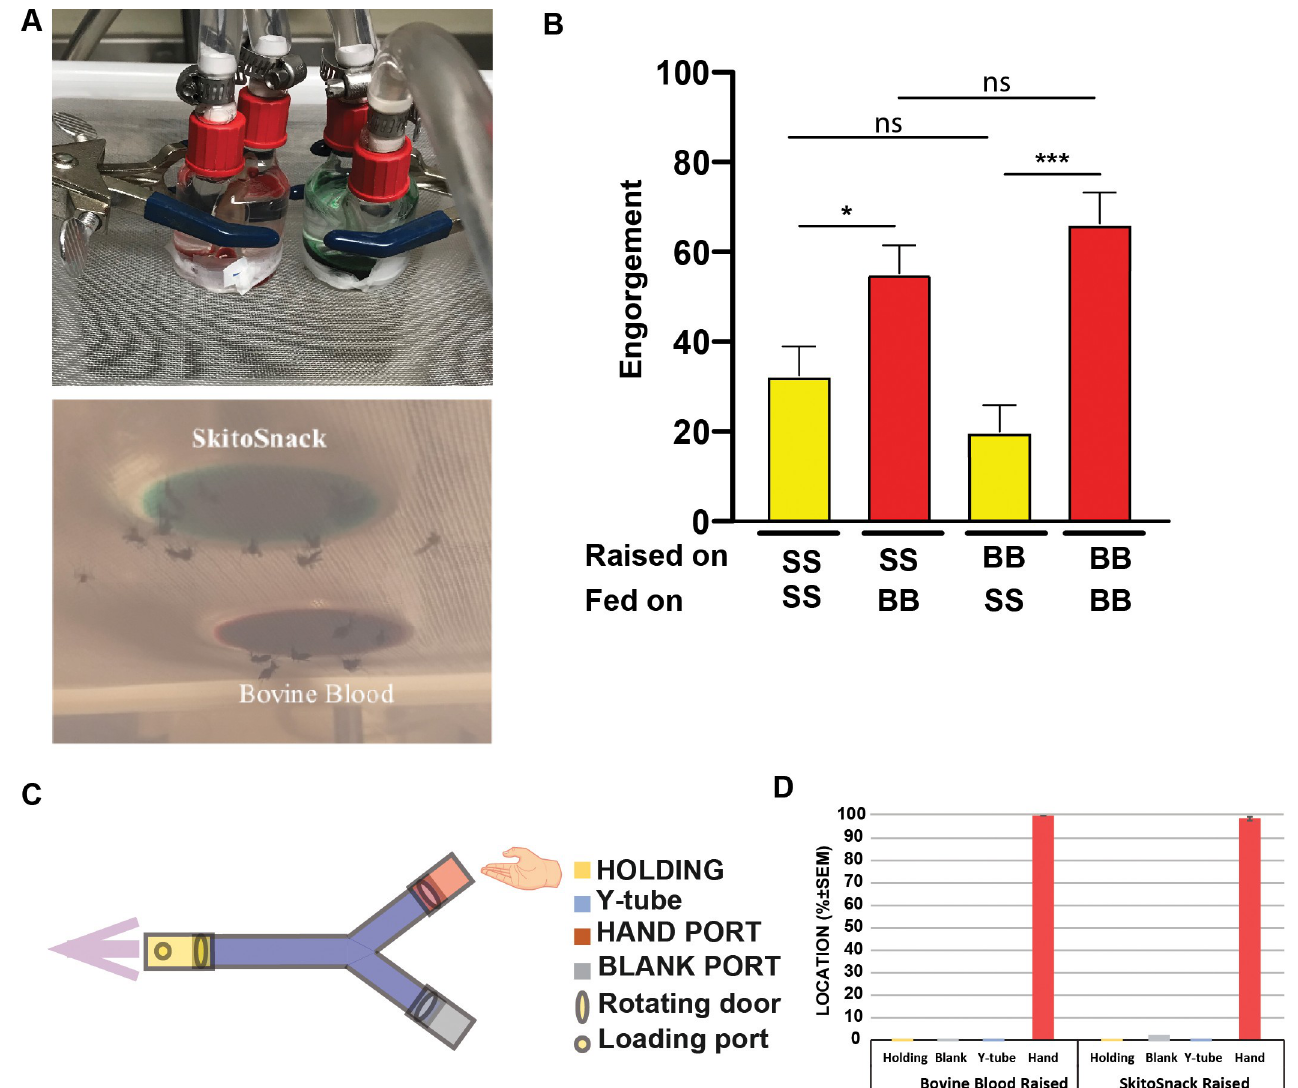
Fig 3. Mosquito meal preference. –(A, upper panel) Experimental setup. The left feeder contains bovine blood, the right SkitoSnack with added green food color. (A, lower panel) The same setup seen from below. (B) Percent engorgement on SkitoSnack (SS) or bovine blood (BB) of mosquitoes raised on these meals. Ns–indicates no significant difference at P < 0.05. (C) Schematic diagram of the experimental setup for Y-tube olfactometer bioassay [21]. The arrow indicates the direction of the air flow. (D) Percent attraction to a human hand in a Y-tube attraction assay of SkitoSnack (SS) raised or bovine blood (BB) raised